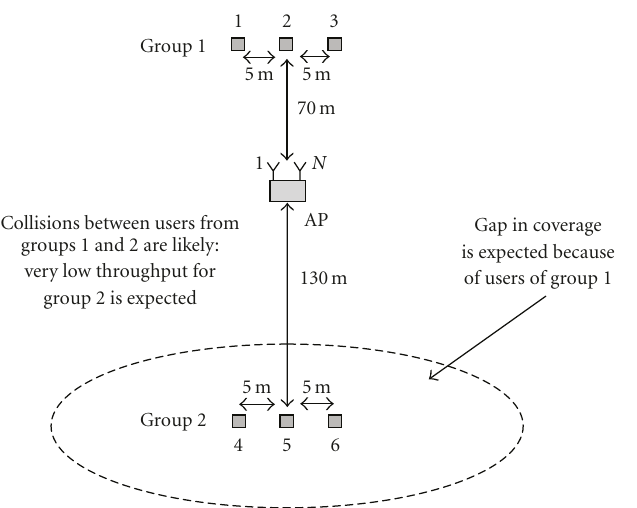
Figure 5: Residential scenario with two groups of visiting users.